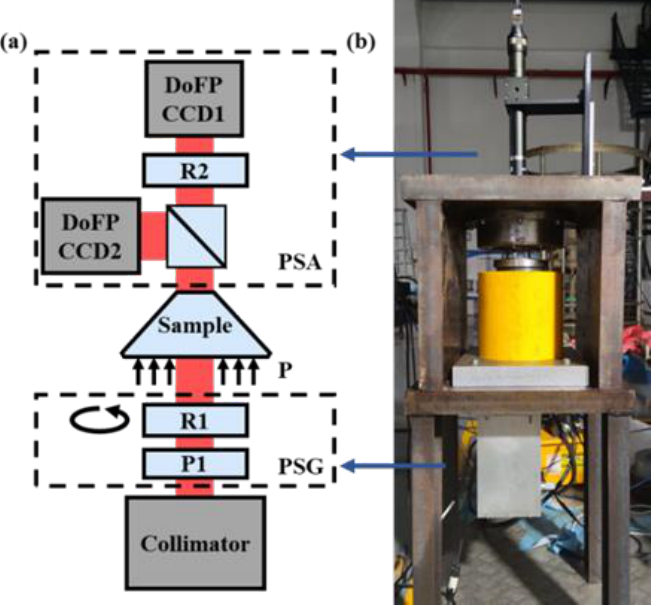
Figure 2. Schematic configuration ( a ) and photograph ( b ) of the experiment setup. P1, polarizer; R1 and R2, achromatic quarter-wave plates.